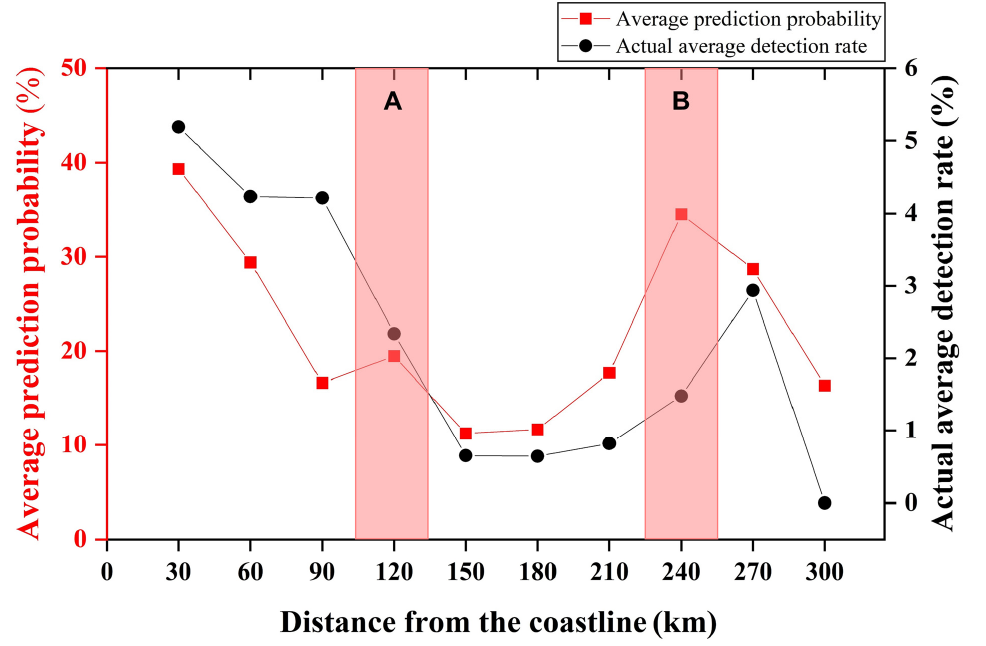
Figure 6. Average of prediction probability within a certain distance and actual average detection rate. Note: The corresponding areas near the peak (A and B) are located in Jinhua and Quzhou, respectively.